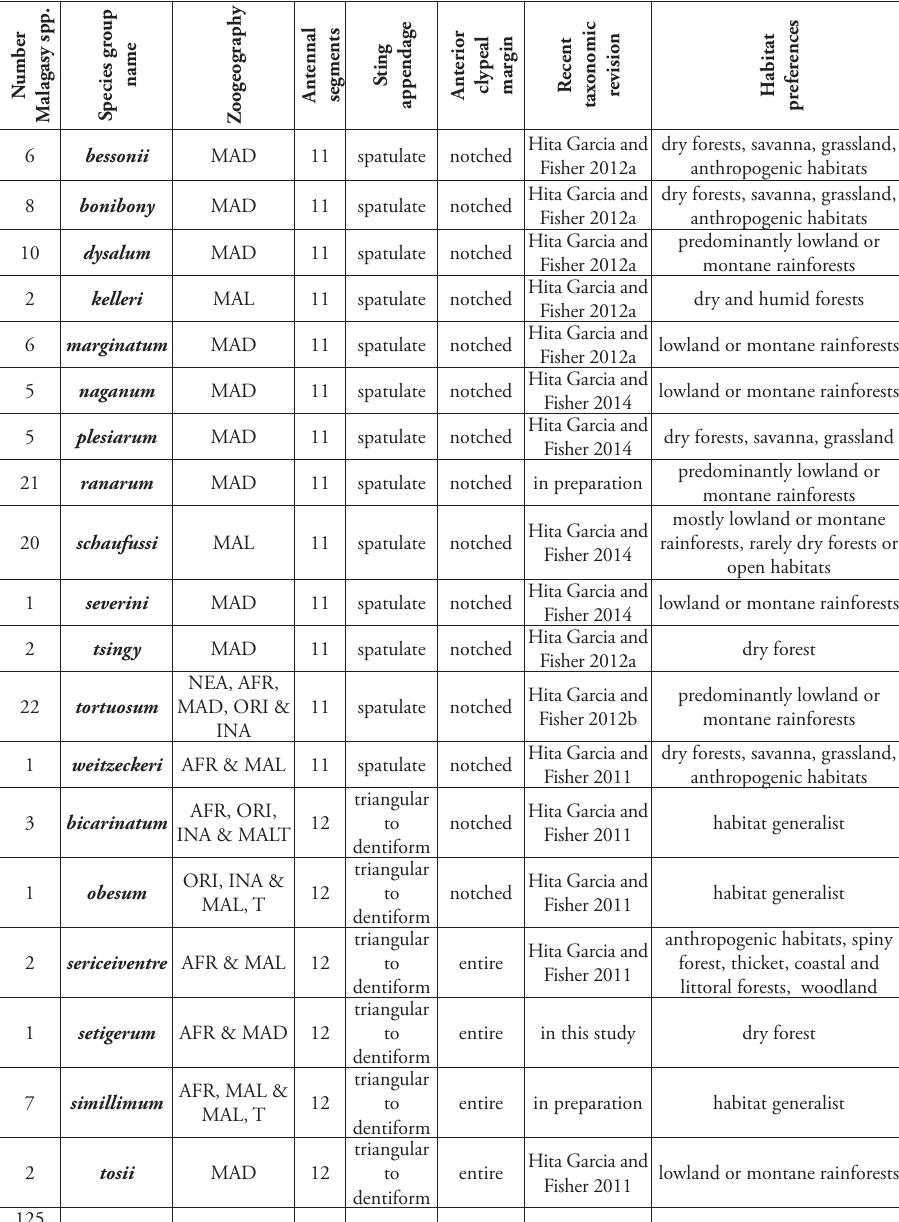
Table 1. Overview of all 19 Malagasy species groups recognised in this study. For each group we provide number of Malagasy species, zoogeographical affinities, number of antennal segments, shape of sting appendage and anterior clypeal margin, the last taxonomic revision, and habitat preferences. The fol- lowing abbreviations are used for zoogeographical affinities: AFR=Afrotropical, INA=Indo-Australian, MAD=only Madagascar, MAL=Malagasy (Madagascar plus islands of the Southwest Indian Ocean), NEA=Nearctic, ORI=Oriental, T=panglobal